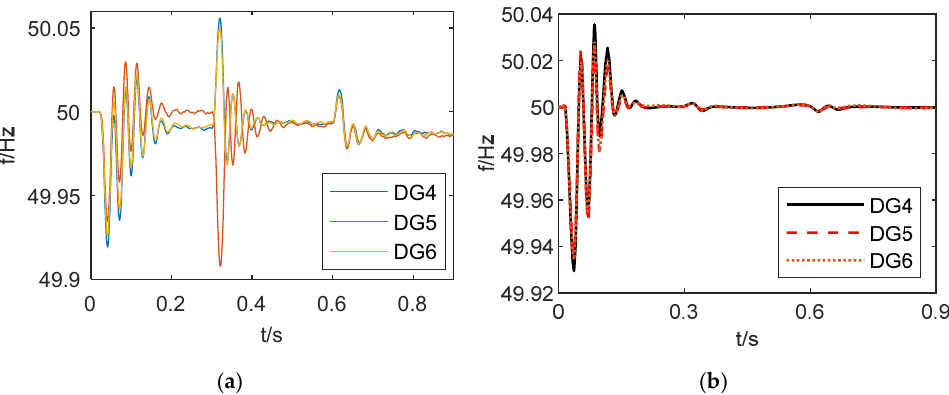
Figure 7. Frequency of each node of AC subnet. ( a ) Frequency of each node of AC subnet under traditional droop control. ( b ) Frequency of each node of AC subnet based on OPPRA.